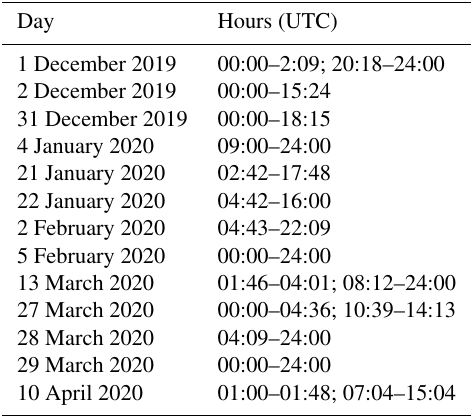
Table 1. Dates and times used from the COMBLE field experiment. Day Hours